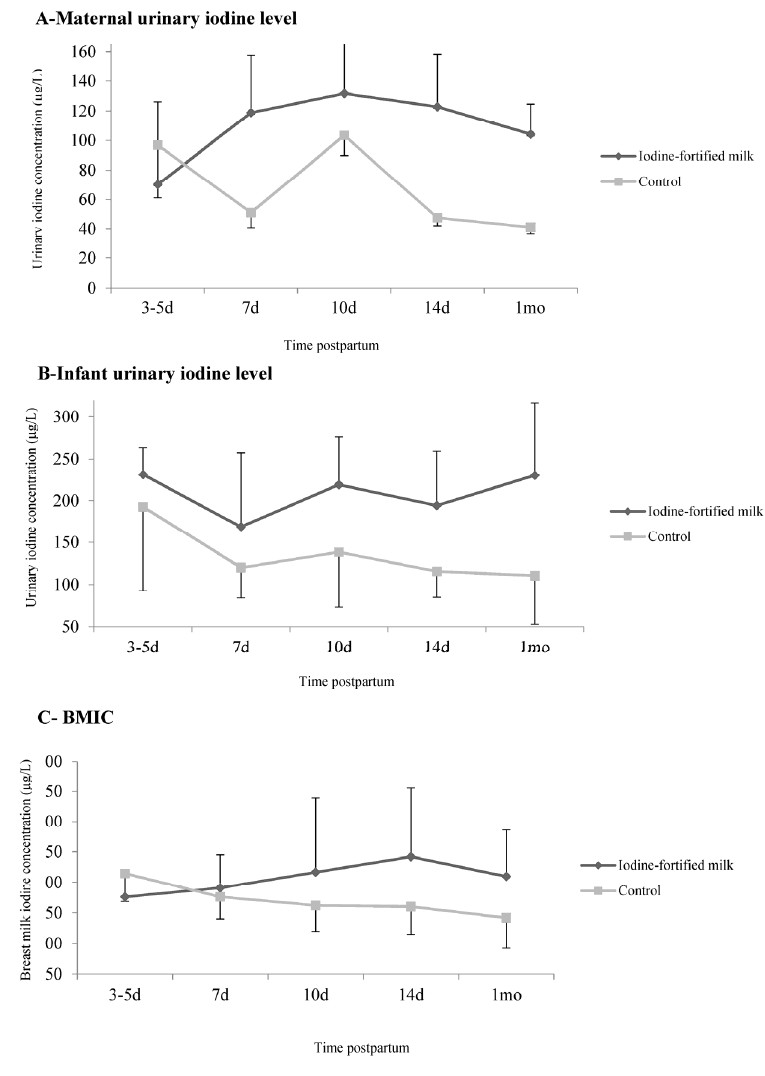
Figure 2. The effect of iodine fortified milk on maternal and infant urinary and breast milk iodine concentrations. ( A ) Urinary iodine concentration ( μ g/L) of mothers; ( B ) urinary iodine concentration ( μ g/L) of infants and ( C ) breast milk iodine concentration ( μ g/L). Data are presented as the median and error bars are the differences between the median, and the 1st and 3rd quartiles.